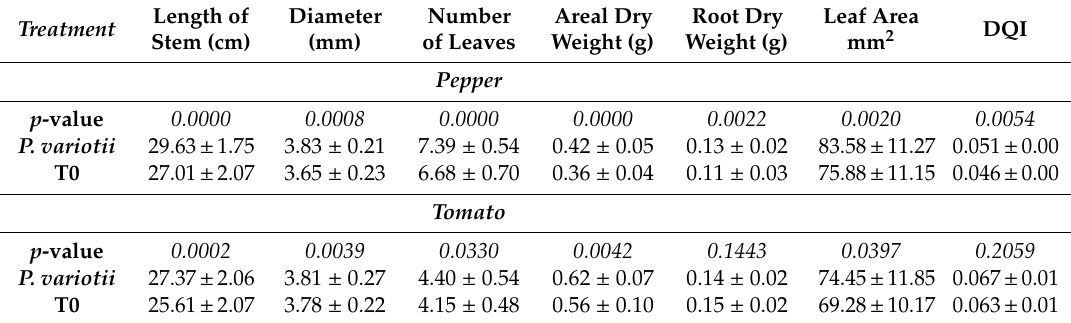
Table 3. Morphological parameters and quality index of pepper and tomato seedlings treated with P. variotii isolate at 45 d after sowing.